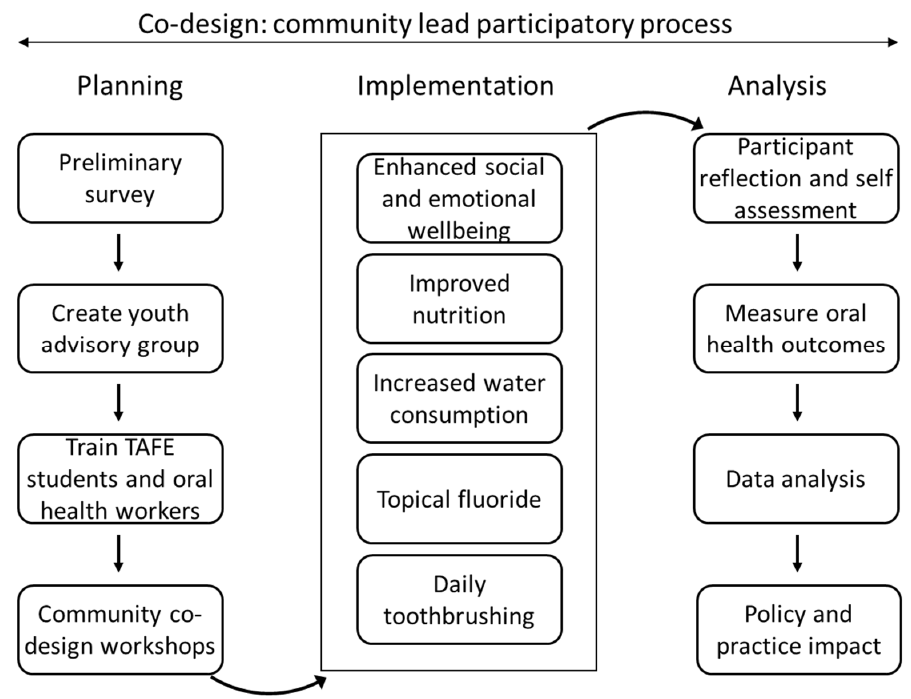
Figure 1. Phases of the Indigenous Adolescent Oral Health Partnership Study